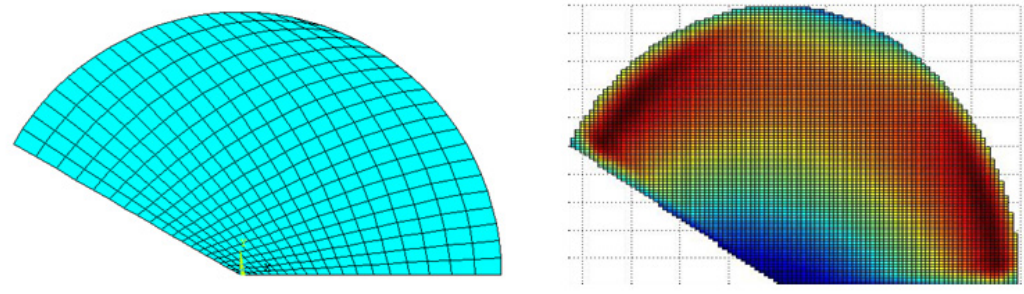
Figure 4: Plot of reaction N in a subdomain